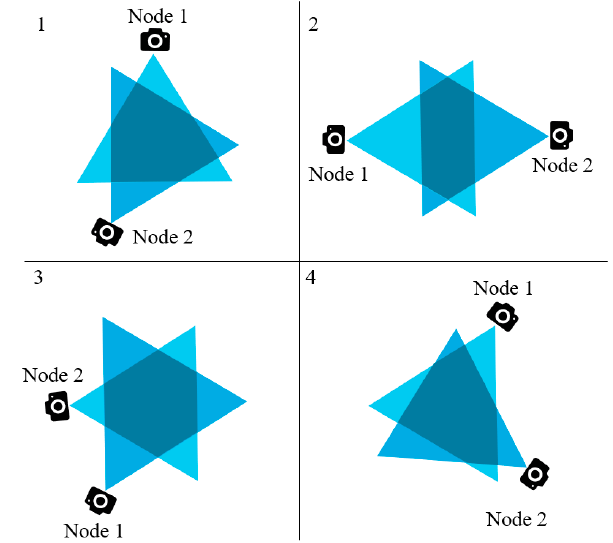
Figure 10. Di ff erent types of polygons created by the overlapped FoVs of two closely placed sensor nodes: ( 1 ) sensor nodes placed vertically opposite to each other; ( 2 ) sensor nodes placed horizontally opposite to each other; ( 3 ) Sensor nodes placed closely to the left side of their orientation; ( 4 ) Sensor nodes placed closely to the right side of their orientation.